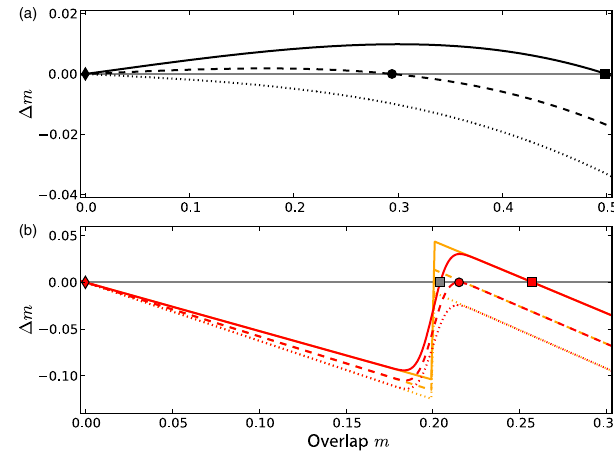
FIG. 5. Nonadditive dendritic coupling increases the overlap m of the network state with a retrieval pattern. Simulation results (circles) and analytical results (solid lines) for linear (black lines and circles) and nonlinear summations with dendritic spike strengths D ∈ f 0 . 4 ; 0 . 6 ; 0 . 8 g (gray, orange, and red lines and circles). The remaining parameters are N ¼ 4000 , B ¼ 2 , θ ¼ 0 . 1 , Θ ¼ 0 . 4 , and Var ½ w (cid:1) ¼ 0 . 1 . Results for linear input summation with Θ ¼ 0 are included for comparison (dash-dotted black line). The setup of the networks is the same as described in the discussion of Fig. 4. (a) The overlap m versus the temperature T for a small load α ¼ N − 1 ≈ 0 . It decreases with increasing T and reaches zero at the critical temperature T c above which retrieval fails. This phase transition is discontinuous for the nonlinear and continuous for the linear model of input process- ing. Dendritic nonlinearities increase T c . (b) m versus α at zero temperature T ¼ 0 . It decreases with increasing load α and displays a discontinuous jump to zero at the critical storage capacity α c . α c increases with stronger dendritic nonlinearities up to a level at which the effective threshold ϑ vanishes and the linear scenario with Θ ¼ 0 is approached (dash-dotted black line).